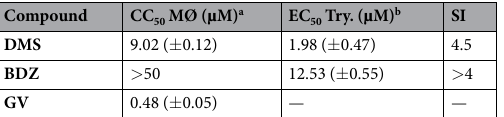
0.48 ( ± 0.05) — — Table 2. Host cell cytotoxicity and trypanocidal activity of DMS on trypomastigotes forms of T. cruzi (Colombian strain). a Cell viability of mouse macrophages determined 72 h after treatment. b Trypanocidal activity determined 24 h after incubation with compounds. b Values represent the mean ± SEM of triplicate. Three independent experiments were performed. EC 50 = effective concentration at 50%. CC 50 = cytotoxic concentration at 50%. BDZ = benznidazole. GV = Gentian